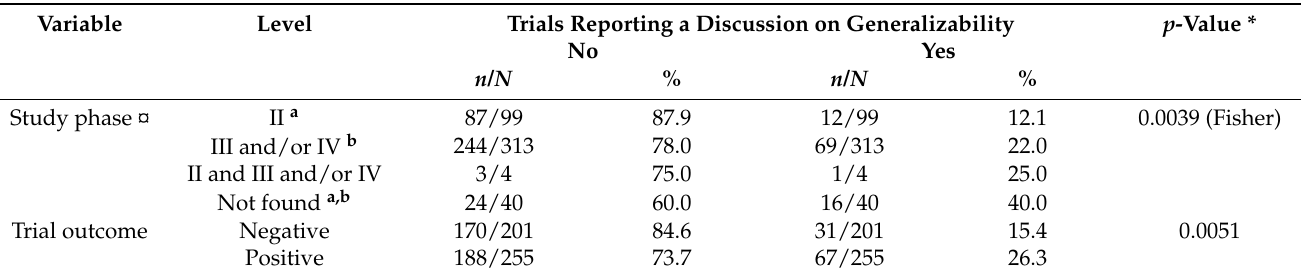
Table 5. Bivariate analyses of variables affecting the reporting of a discussion on the generalizability of the trial